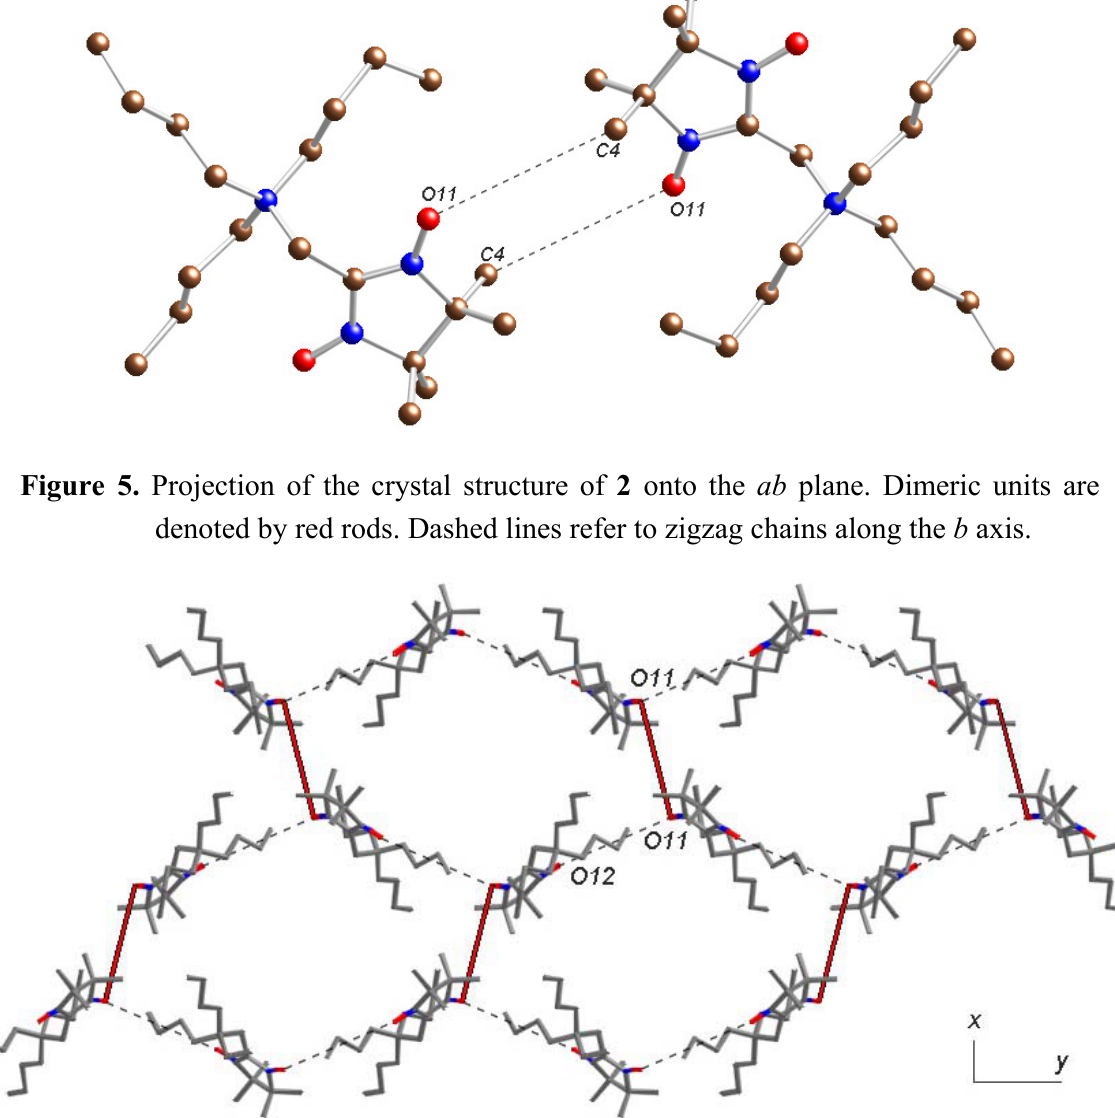
Figure 4. View of the centrosymmetric n Bu